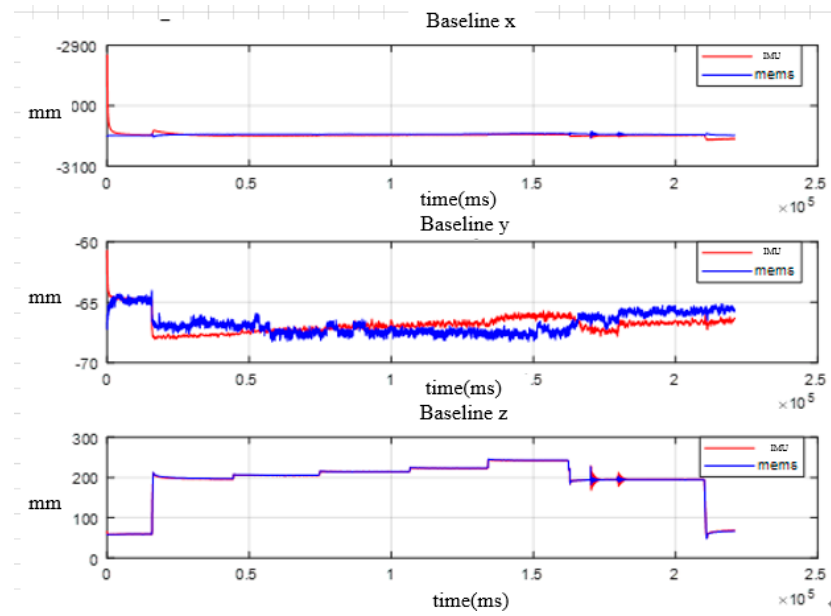
Figure 19. Comparison of wing deformation measurement. Table 4. Transfer alignment between main POS and MEMS (°).